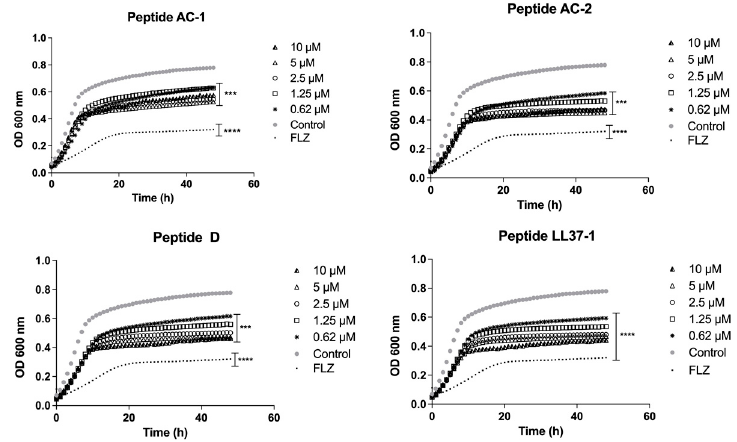
Figure 1. Growth curves of C. albicans ATCC 10231. Four LL-37 analogue peptides (AC-1, AC-2, D, and LL37-1) were tested at different concentrations (10, 5, 2.5, 1.25, and 0.62 µM). C. albicans ATCC 10231 cells without exposure to antimicrobial peptides were used as a control. Fluconazole (64 µg/mL) was used as antifungal control. Data represent three independent experiments. Statistical significance *** p < 0.001; **** p < 0.0001 when compared to control.